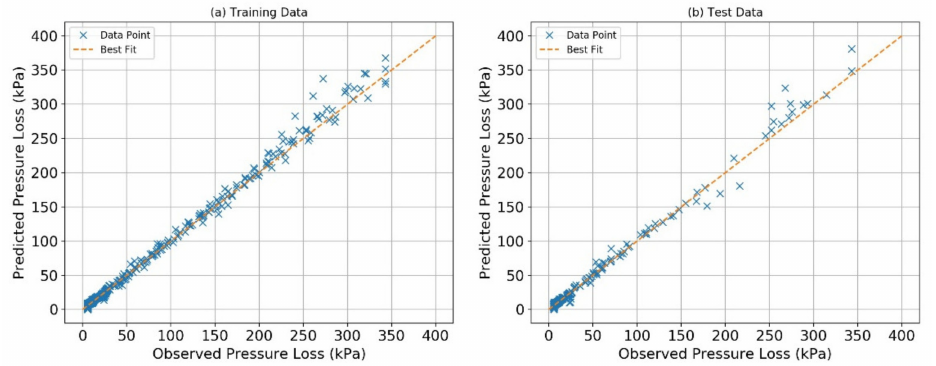
Figure 6. BNN predicted pressure plotted with observed pressure loss: ( a ) training dataset and ( b ) test dataset.